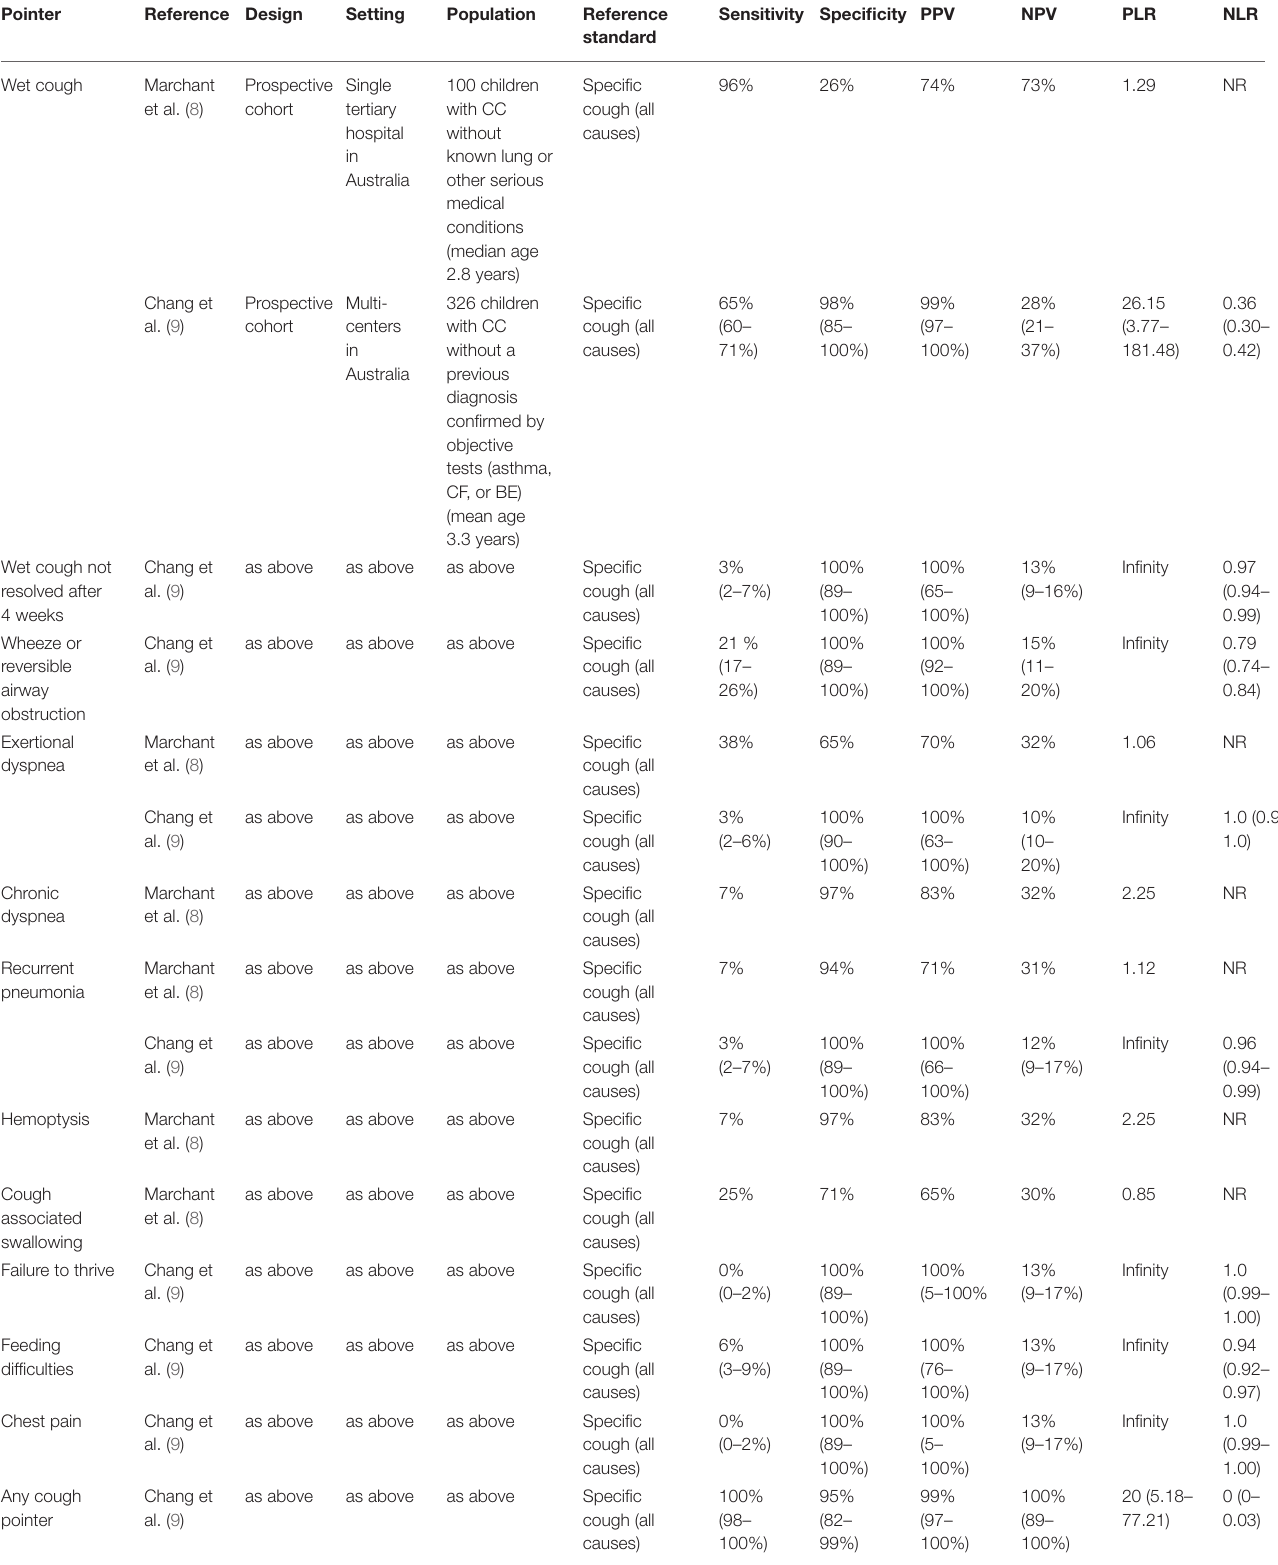
TABLE 1 | Utility of specific cough pointers in differentiating specific coughs from non-specific coughs in children with chronic